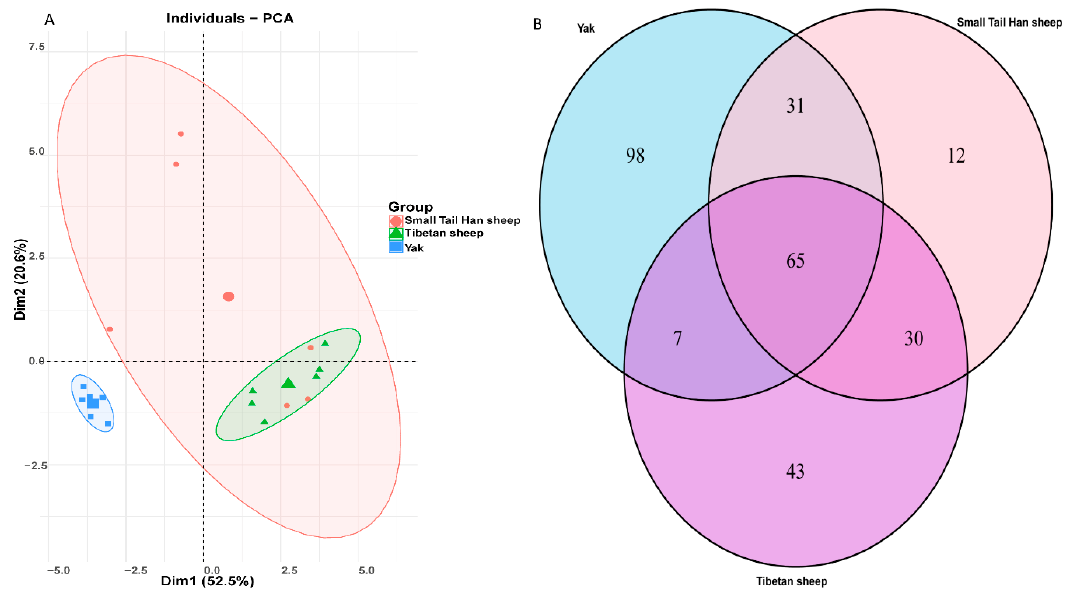
Figure 1. Two-dimensional Principal component analysis (PCA) based on Bray − Curtis distance metrics ( A ); Venn diagrams of OTUs composition ( B ).